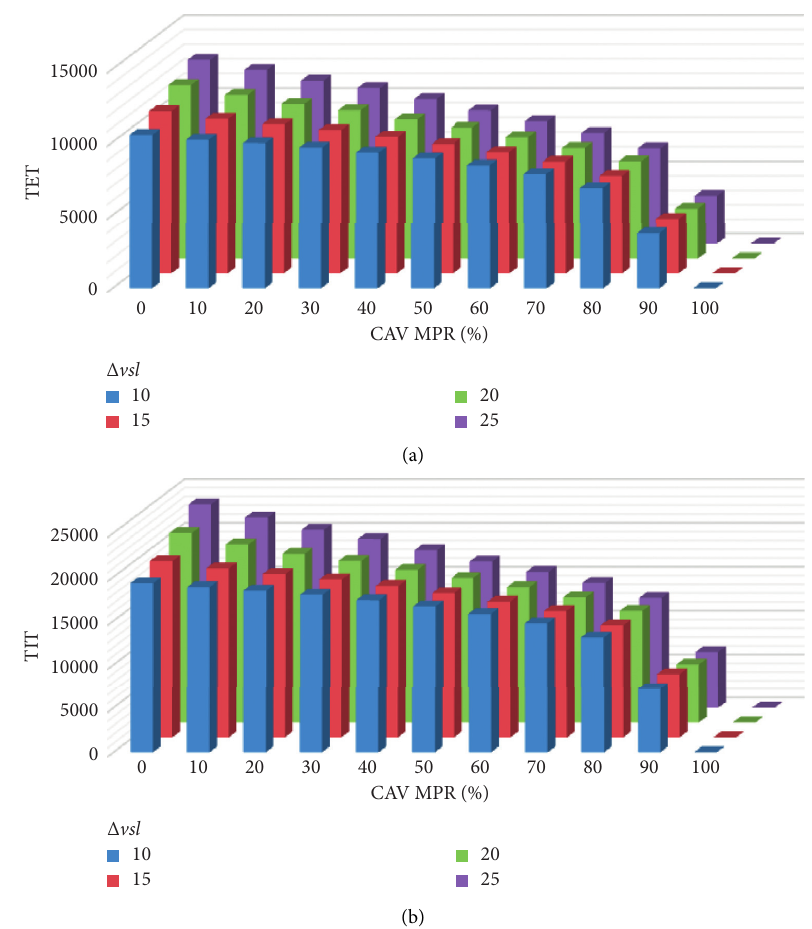
Figure 9: The results of sensitivity analysis of Δ